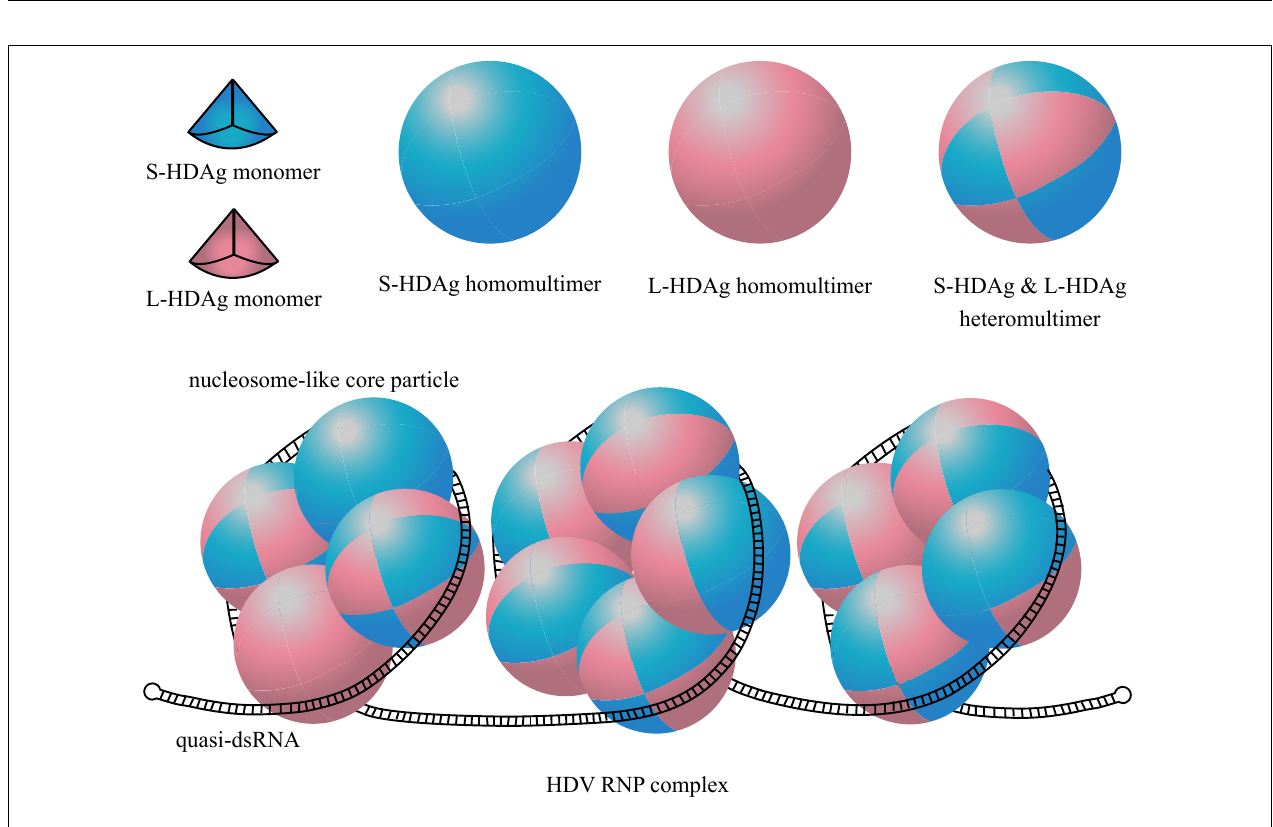
FIGURE 2 | Structure of HDAg multimers and HDV ribonucleoprotein (RNP) complex. One eighth of the sphere represents a HDAg monomer, the blue one represents S-HDAg, the pink one represents L-HDAg. A HDAg octamer containing 8 S-HDAg or 8 L-HDAg is called homomultimer, and is called heteromultimer when it contains a mix of S-HDAg and L-HDAg. Quasi-double-stranded RNA (quasi-dsRNA) wrap around four or five HDAg octamers as a nucleosome-like core particle, and the whole HDV RNP contain 2–6 such core particles.